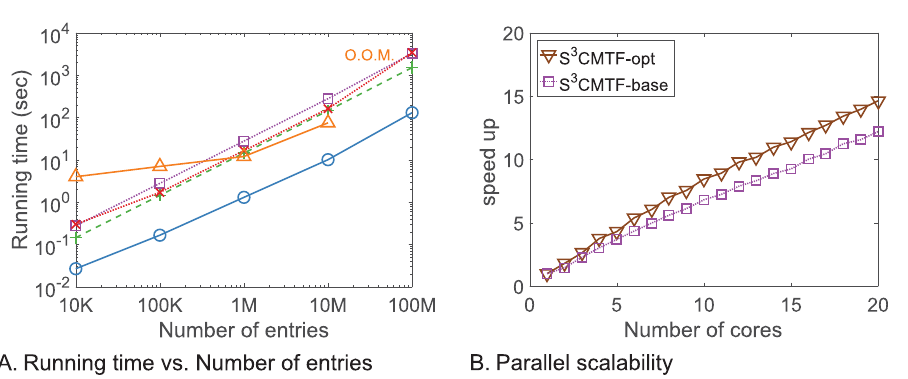
Fig 6. Comparison of scalability. (a) S 3 CMTF shows linear scalability as the number of entries increases. (b) S 3 CMTF-base and S 3 CMTF-opt show linear speed up as the number of cores grows. O.O.M.: out of memory error.